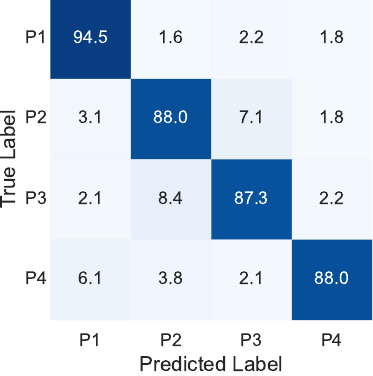
Figure 8. Confusion matrix of first step (%).